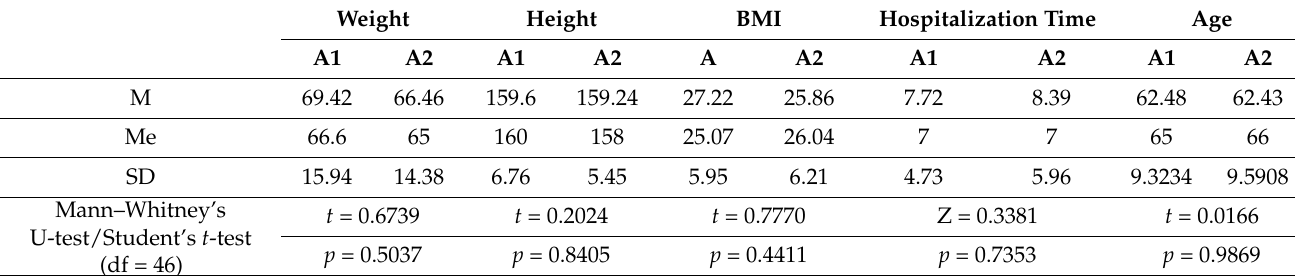
Table 2. Weight, height, BMI, hospitalization time, and